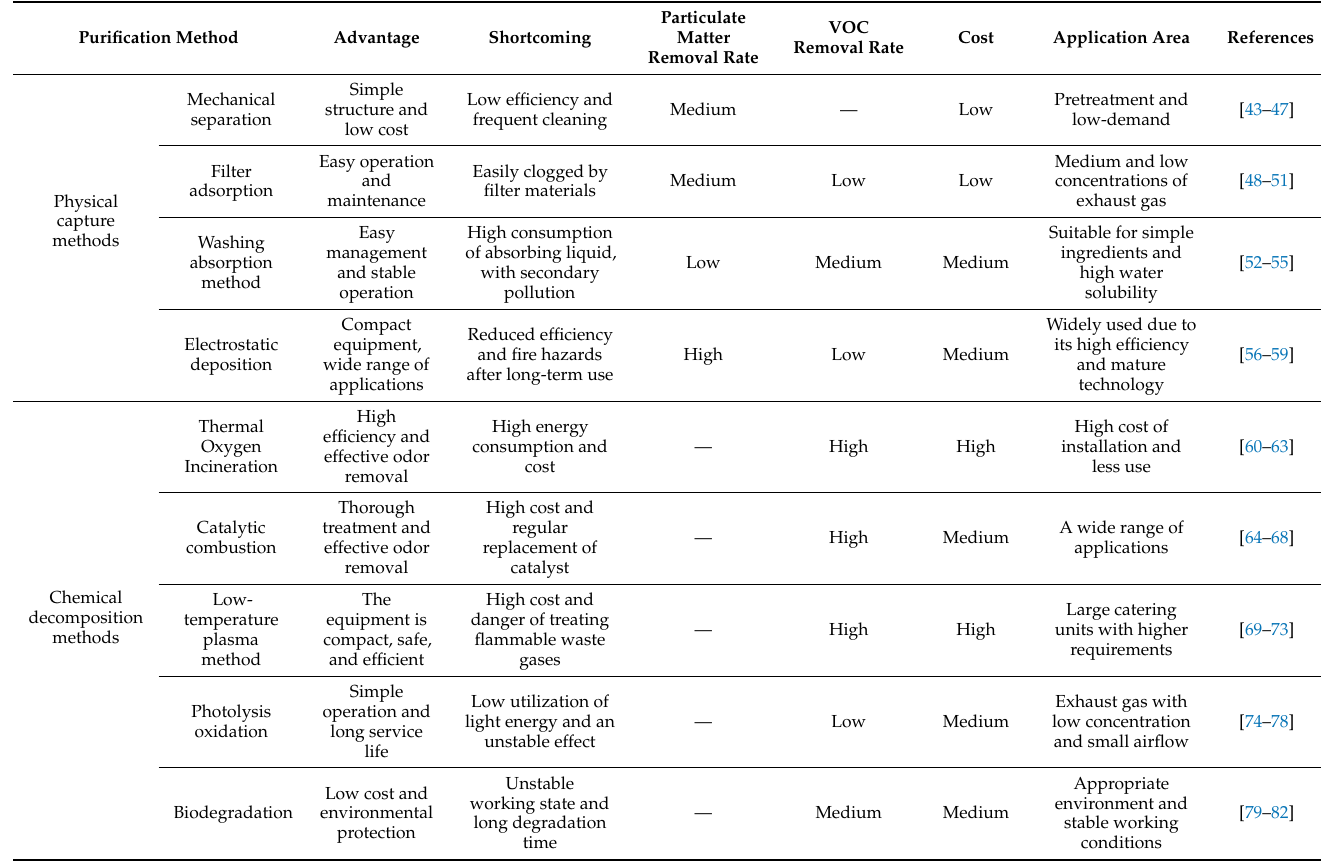
Table 2. Characteristics of cooking oil fume pollutant purification